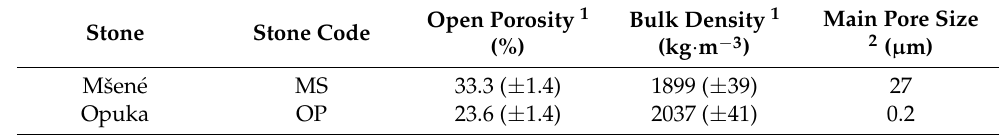
Table 1. Porosity, bulk density, and main pore size of the stones [21].